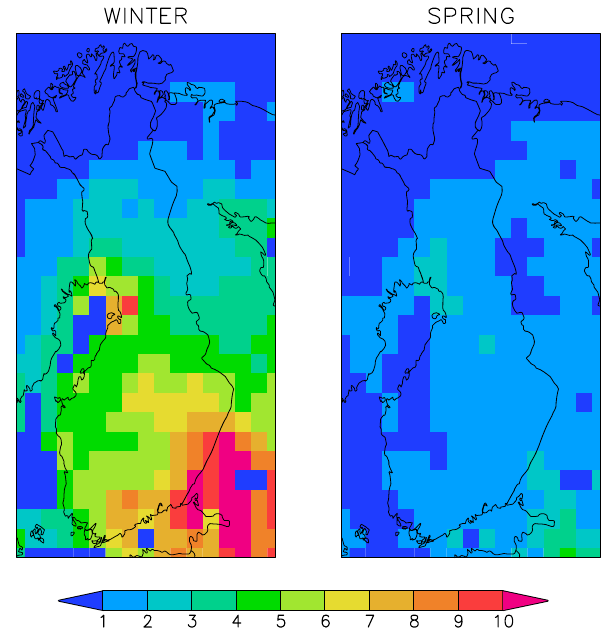
Fig. 20. Modelled black carbon deposition flux on snow [mg/m 2 ] over Finland for winter and spring